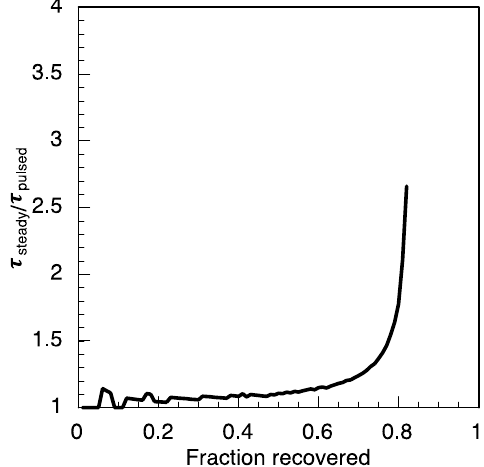
Figure 2. Average fraction of contaminant recovered from the vertical circulation well (VCW) (Figure 1) from three trials each under steady (solid) and rapidly pulsed (dashed) flow.